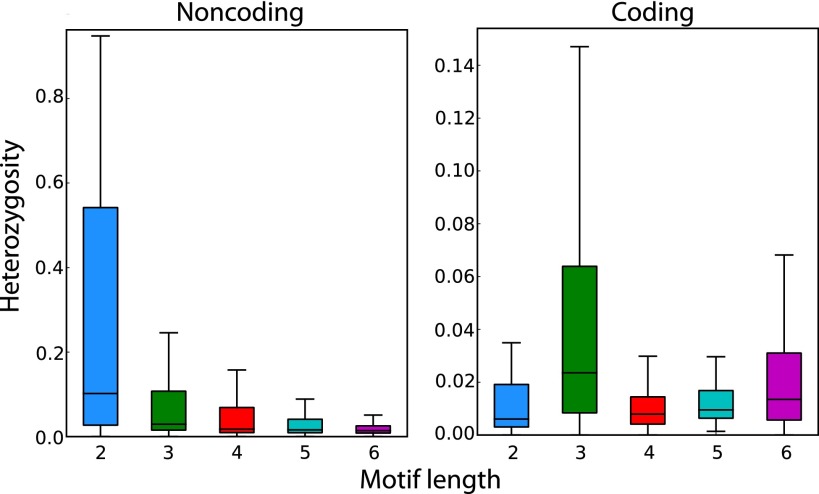
Motif length and coding capabilities as determinants of STR variability. STR heterozygosity monotonically decreases with motif length for noncoding loci and is generally reduced in noncoding (left) versus coding regions (right). The box extends from the lower to upper quartiles of the heterozygosity distribution, and the interior line indicates the median. The whiskers extend to the most extreme points within 1.5*IQR of the quartiles.